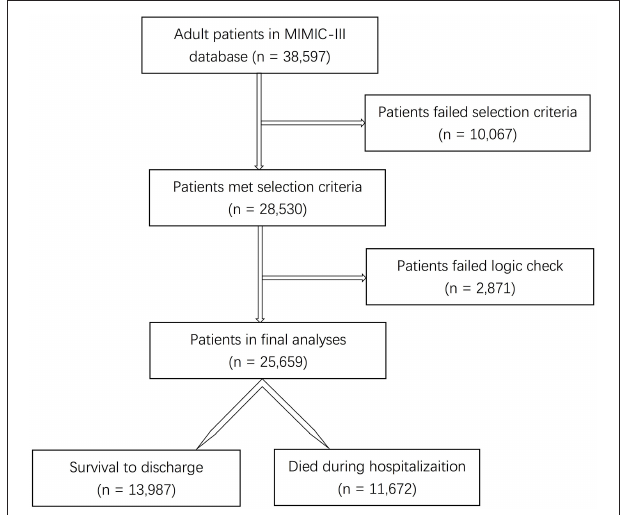
FIGURE 1 | Flow diagram of the selection process of